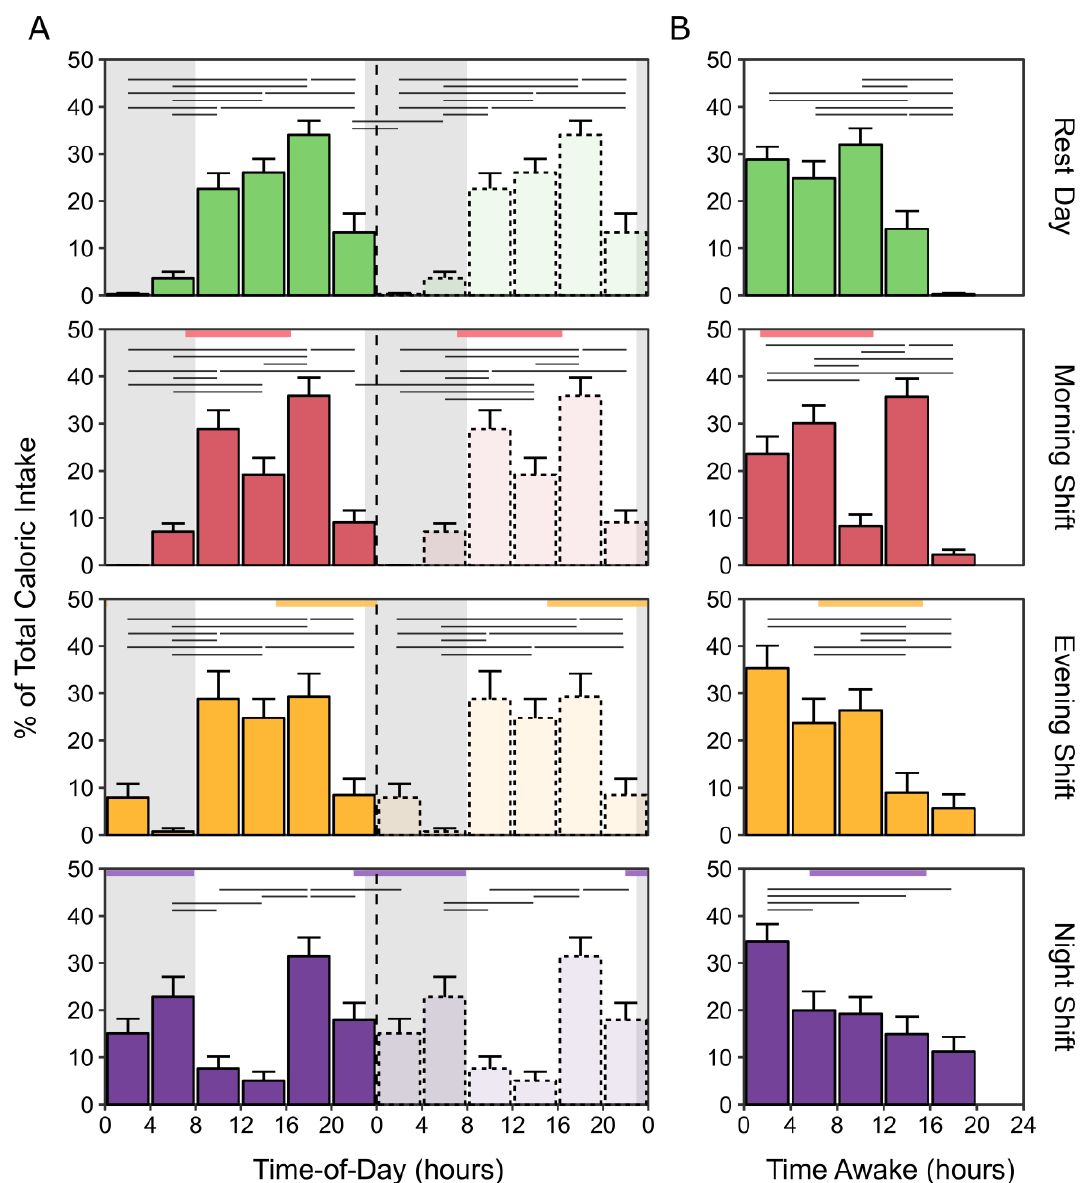
Figure 4. Distribution of calories by time-of-day (double-plotted) and time awake per day type. Percentages of total caloric intake on rest days, morning-shift days, evening-shift days, and night-shift days are depicted along the abscissa in 4-h bins by ( A ) time-of-day, replotted on the right, and ( B ) time awake. Grey regions represent the average sleep periods on rest days. Colored horizontal rectangles indicate the average work start and end times for each shift type. Horizontal black lines indicate significant di ff erences (adjusted, p < 0.05) in the proportion of total calories consumed between time-of-day or time awake bins. Error bars represent the standard error of the mean. Mixed-e ff ects analyses revealed significant interactions of day type with time awake for the percentage of total caloric intake (F(12,440) = 6.66, p < 0.001) and the percentages of total